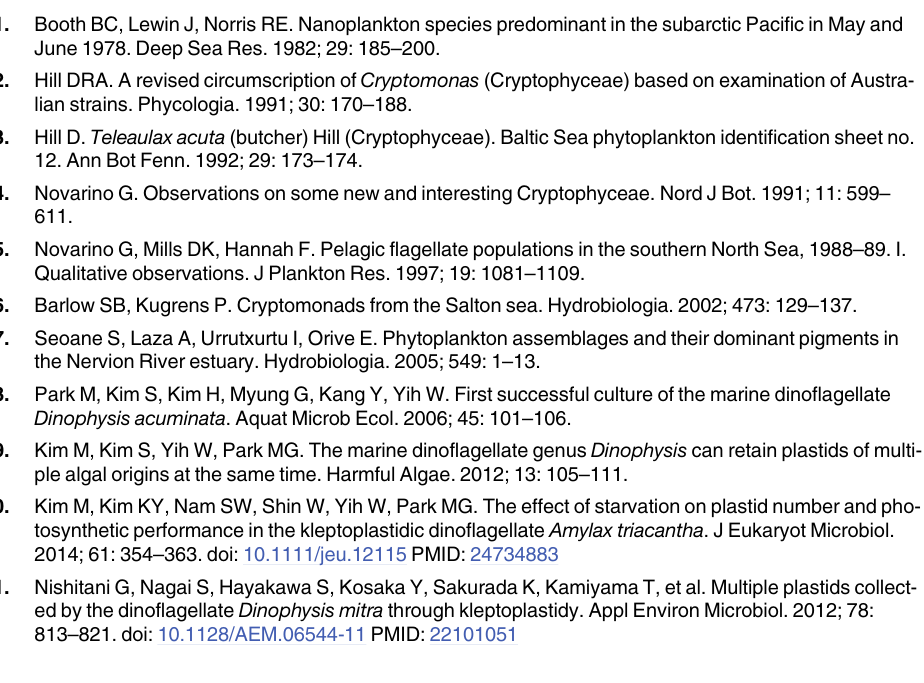
S1 Fig. The phylogenetic tree constructed from 90 dna X homologs. RAxML bootstrap values are shown above the branches with > 50% support. The scale bars indicate the number of sub- stitutions/amino acid site. S1 Table. Cryptophyte plastid genome alignments. S2 Table. Concatenated data set of protein-coding genes for constructing phylogenetic tree. S3 Table. Evolutionary models, log likelihood values (-lnL), and model parameters pro- posed by ProtTest3 for amino acids [61] and Modeltest 3.7 for nucleotides [93]. S4 Table. The gene contents and arrangement of the Teleaulax amphioxeia plastid